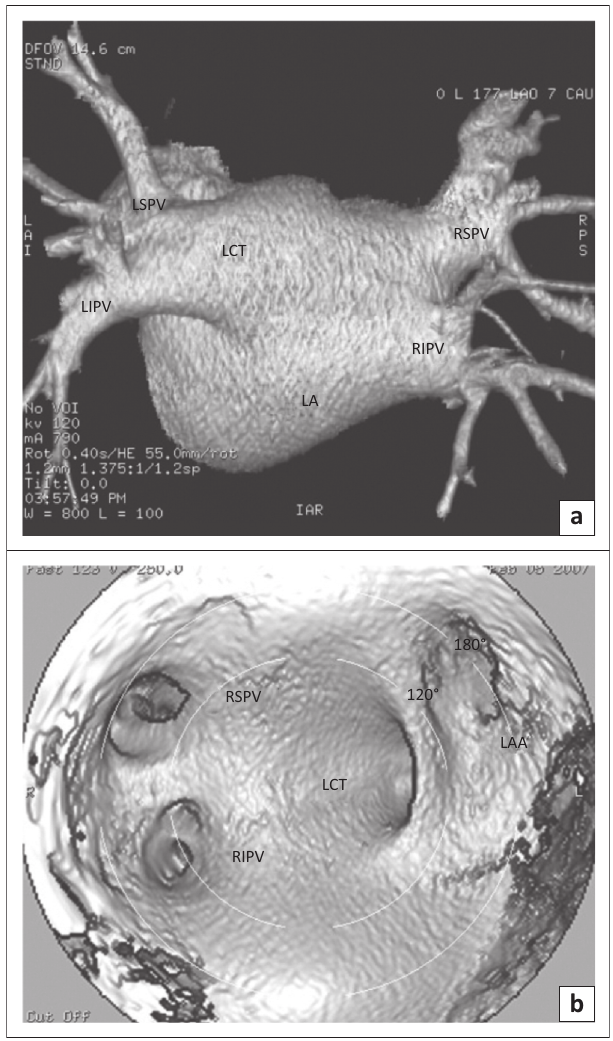
LSPV, left superior pulmonary vein; LIPV, left inferior pulmonary vein; LCT, left common trunk; RSPV, right superior pulmonary vein; RIPV, right inferior pulmonary vein; LA, left atrium; LAA, left atrial appendage. FIGURE 9: Common left trunk in a 53-year-old woman with atrial fibrillation: (a) Three-dimensional image. Left superior pulmonary vein (LSPV), left inferior pulmonary vein (LIPV), left common trunk (LCT), right superior pulmonary vein (RSPV), right inferior pulmonary vein (RIPV), left atrium (LA); (b) Three- dimensional model. Right superior pulmonary vein (RSPV), right inferior pulmonary vein (RIPV), left common trunk (LCT) and left atrial appendage (LAA).